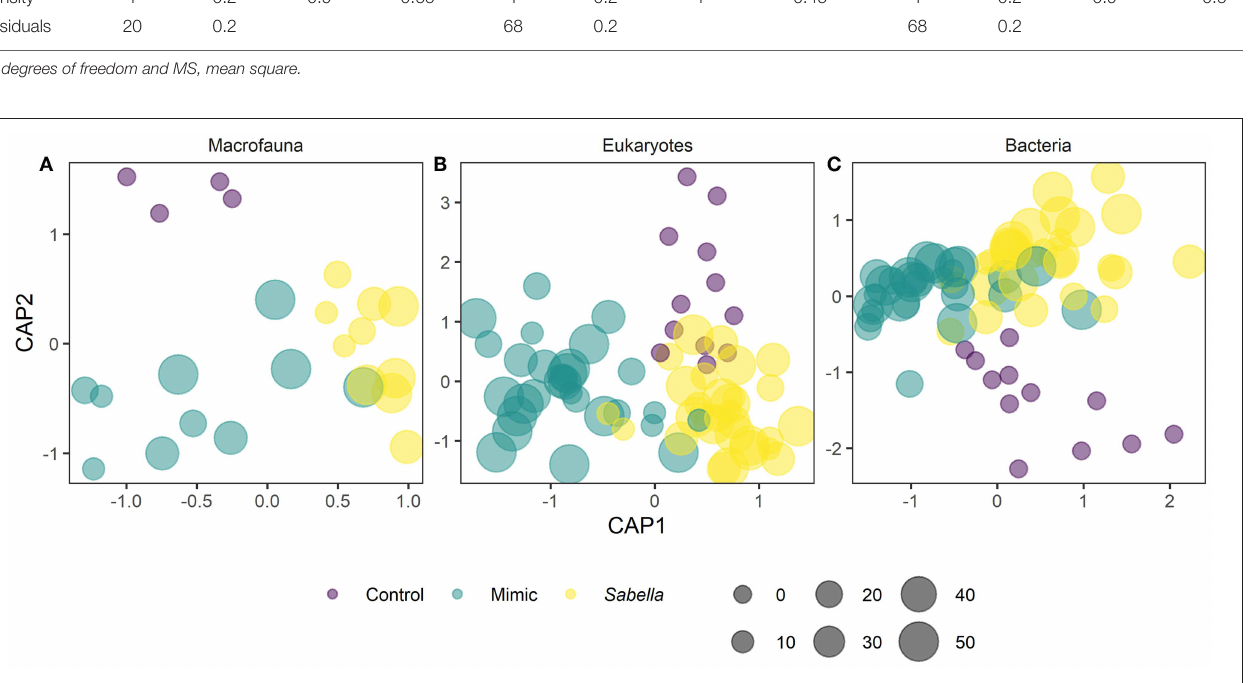
FIGURE 3 | Principal coordinate ordination (PCO) and Canonical analysis of principal coordinates of assemblages in “Control” (purple circles), “Mimic” (green circles) and “ Sabella ” (yellow circles) experimental plots on the basis of Bray–Curtis similarities of the log (x + 1) transformed abundance of macrofauna (A) , eukaryotes (B) , and bacteria (C)